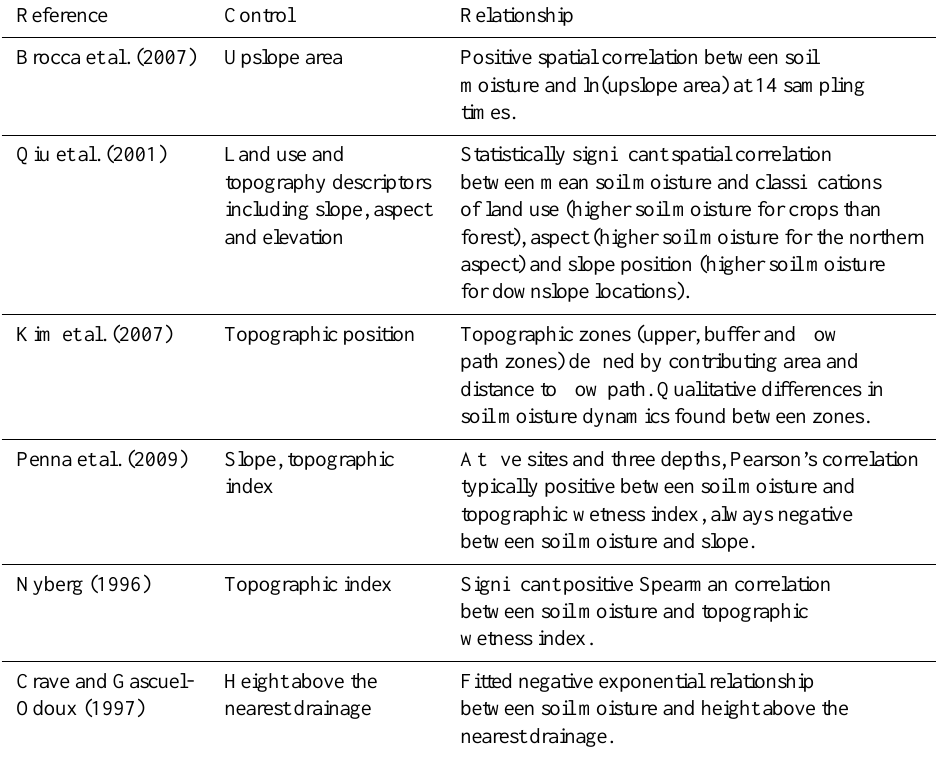
Table 1. Examples of controls on soil moisture distribution found in international studies. Reference Control Relationship Brocca et al. (2007) Upslope area Positive spatial correlation between soil moisture and ln(upslope area) at 14 sampling times. Land use and Statistically significant spatial correlation topography descriptors between mean soil moisture and classifications including slope, aspect of land use (higher soil moisture for crops than and elevation forest), aspect (higher soil moisture for the northern aspect) and slope position (higher soil moisture for downslope locations). Kim et al. (2007) Topographic position Topographic zones (upper, buffer and flow path zones) defined by contributing area and distance to flow path. Qualitative differences in soil moisture dynamics found between zones. Penna et al. (2009) Slope, topographic At five sites and three depths, Pearson’s correlation index typically positive between soil moisture and topographic wetness index, always negative between soil moisture and slope. Nyberg (1996) Topographic index Significant positive Spearman correlation between soil moisture and topographic wetness index. Crave and Gascuel- Height above the Fitted negative exponential relationship Odoux (1997) nearest drainage between soil moisture and height above the nearest